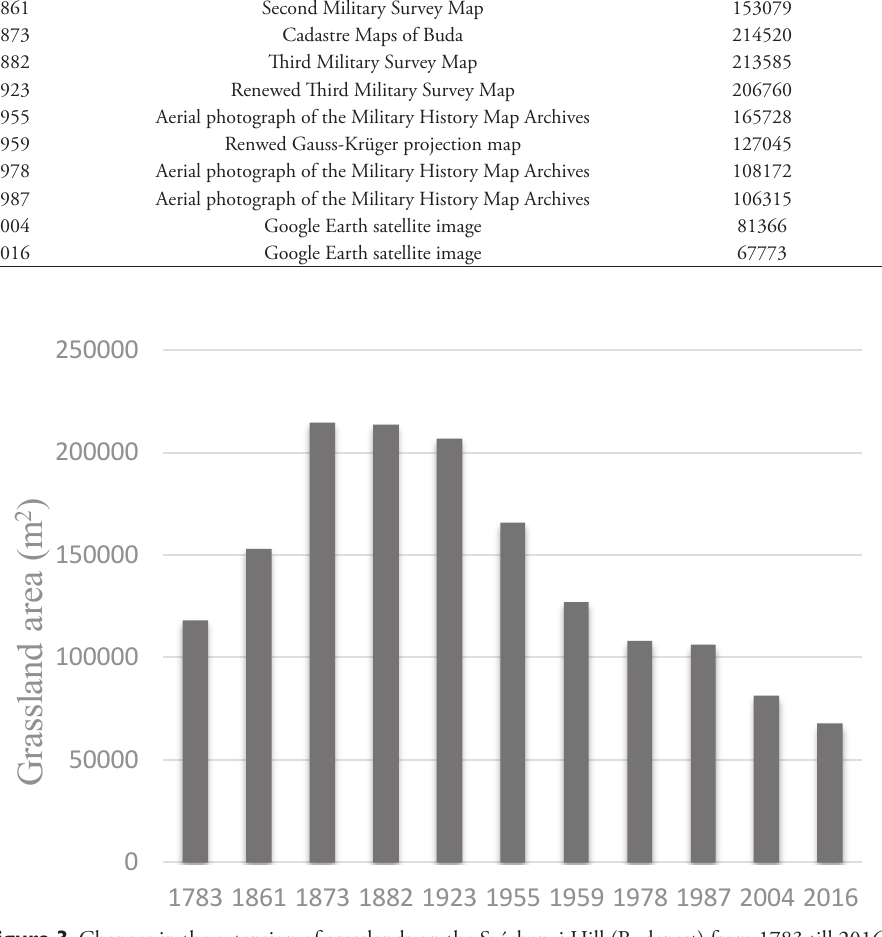
Figure 3. Changes in the extension of grasslands on the Széchenyi Hill (Budapest) from 1783 till